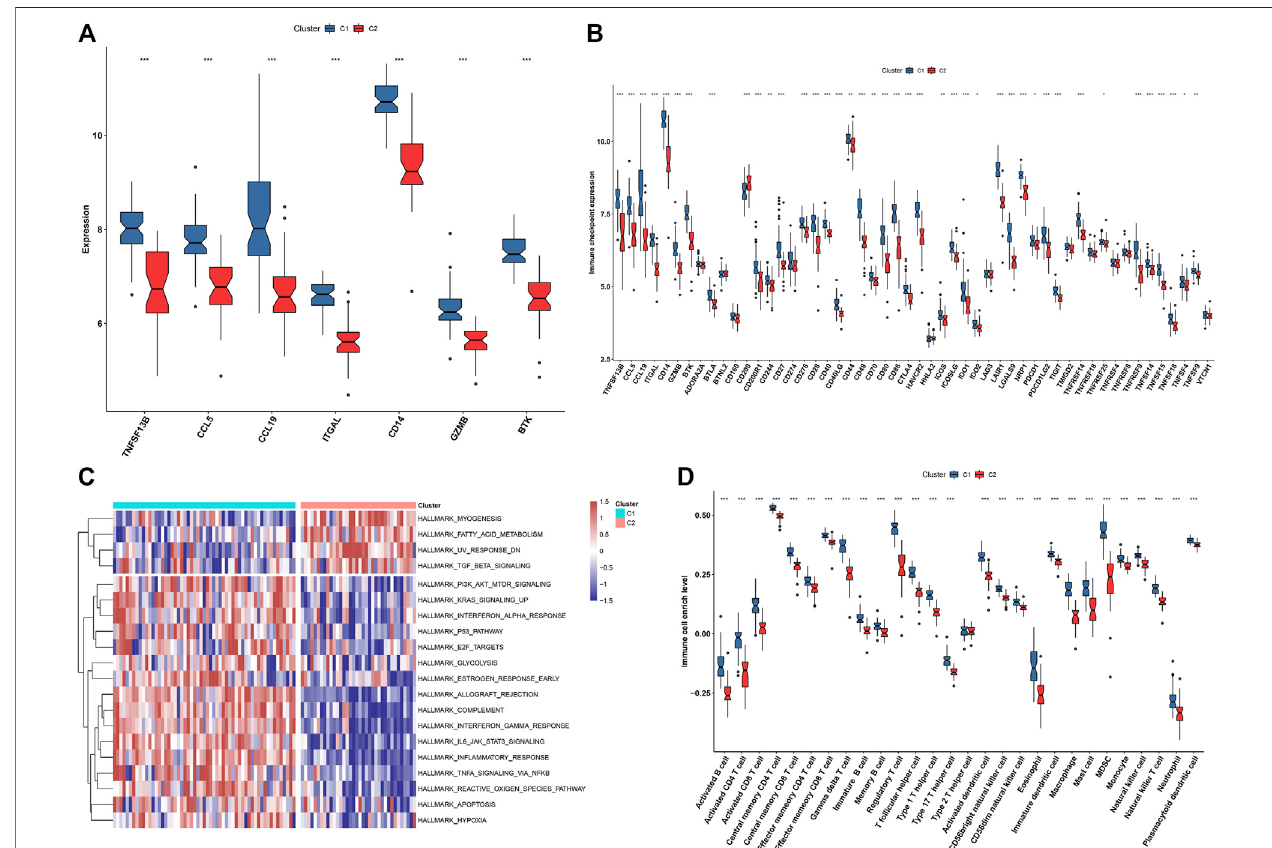
FIGURE 9 | Two immune subtypes characterized by different immunological featuresand molecular mechanisms. (A) Box plots showing the mRNA expression of characteristic genesin twoimmune subtypes. (B) Boxplots showing themRNA expression ofimmunecheckpoints in twoimmunesubtypes. (C) Heatmap showing the enrichment levels of hallmark gene sets in two immune subtypes. (D) The box plots demonstrating the in fi ltration levels of immune cell components in two immune subtypes. * p < 0.05; ** p < 0.01; and *** p < 0.001.